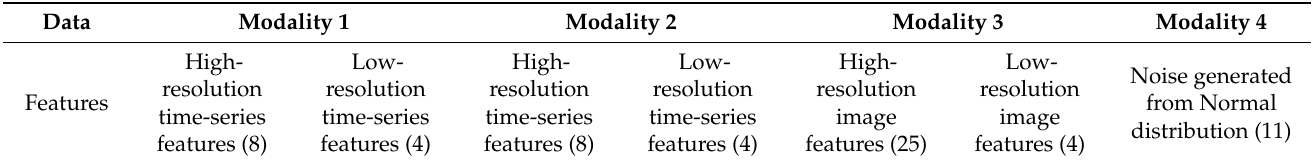
Figure 2. The simulated thermal distribution Signal. Table 2. Data Summary in Simulation (number of features is shown in